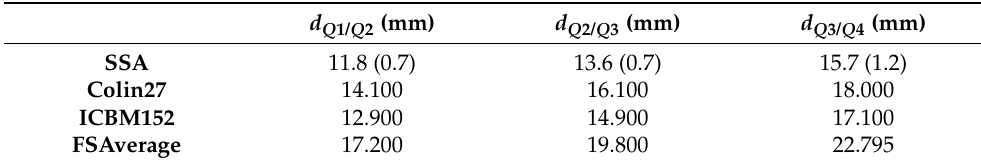
Table 4. Separation values between depth quartiles. Results for SSA case are expressed as median (IQR) across all subjects.